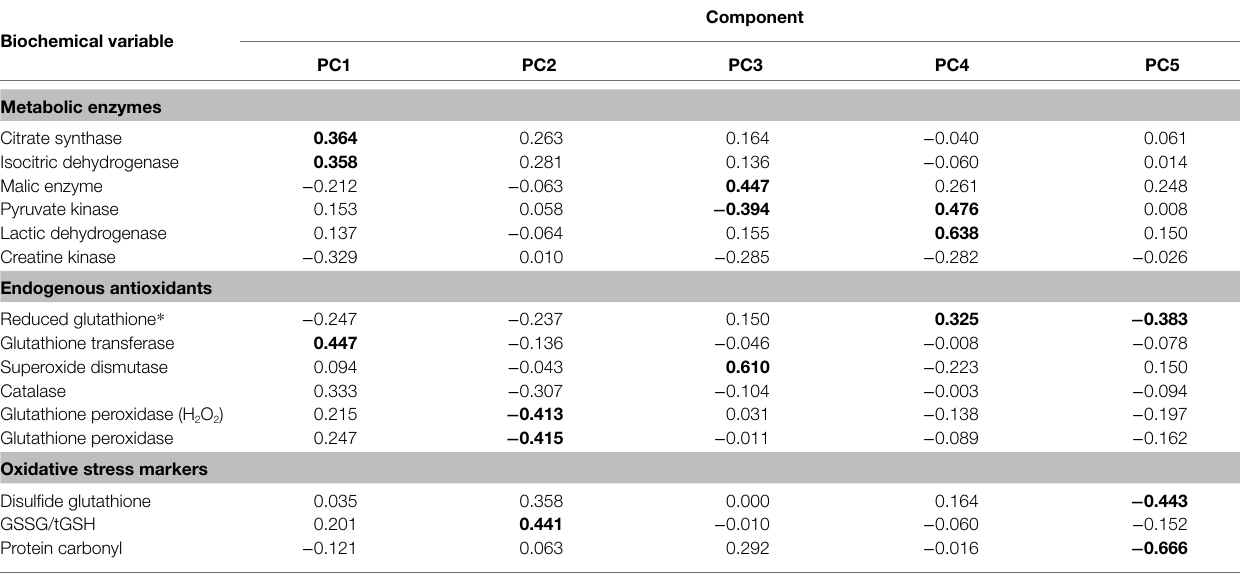
TABLE 3 | Principal components and coefficients for each biochemical variable measured in the skeletal muscle of active and estivating frogs of the two species.